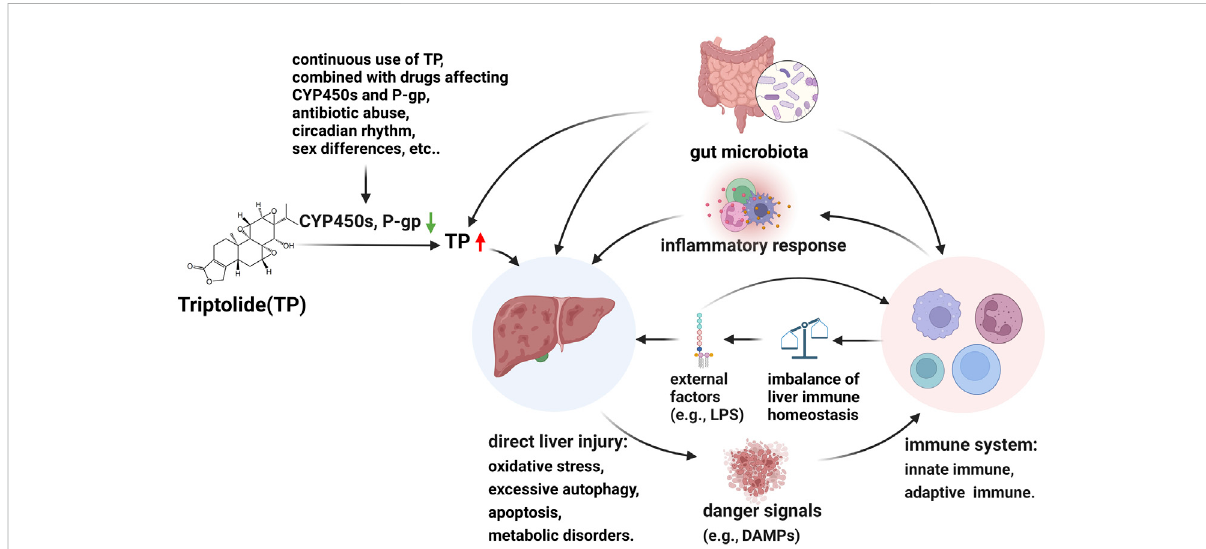
FIGURE 2 Hypothesis of molecular pathogenesis of TP-induced hepatotoxicity. CYP450 enzymes are involved in TP metabolism and P-gp is involved in TP transport. Some factors such as the continuous use of TP, combined with drugs affecting CYP450s and P-gp, antibiotic abuse, circadian rhythm, and sex differences, should affect the level of TP in the liver. TP itself is hepatotoxic and direct liver toxicity due to excessive exposure to TP, such as oxidative stress,excessive autophagy, apoptosis, metabolic disorders,etc.Celldamagecausedbydirecthepatotoxicity releasesdangersignals, such as DAMPs, which can activate the innate and adaptive immune systems, and then a large number of pro-in fl ammatory factors will be released. The in fl ammatory response further aggravates liver injury by promoting cell death, inducing excessive autophagy and metabolic disorders, etc. In addition,theimbalanceofhepaticimmunehomeostasiscausedbychangesinimmunecellsmakestheliversensitivetoexternalfactors,suchasLPS, then aggravates hepatotoxicity. Furthermore, gut microbiota mediates the hepatotoxicity of TP by affecting TP in vivo exposure, metabolic homeostasis, and immunity. ↓ : downregulation of CYP450s and p-gp; ↑ : abnormal increase TP